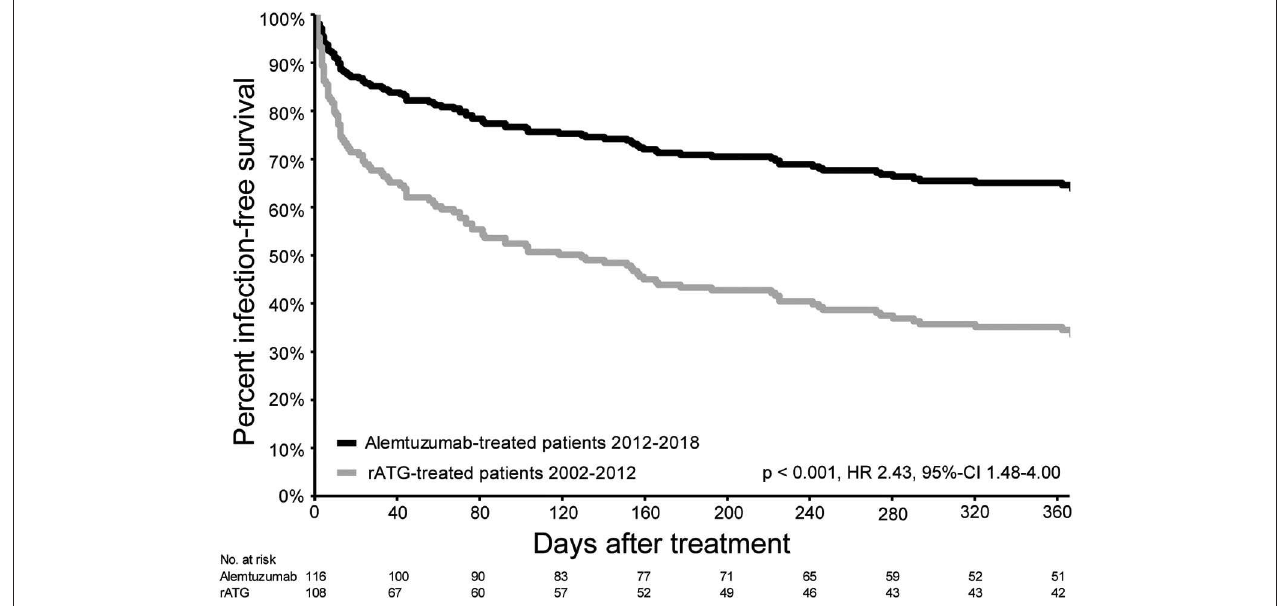
FIGURE 4 | Infection-free survival in the first year after treatment for acute rejection. Infection-free survival (excluding CMV, EBV, and BK virus infections) of patients with AR and treated with alemtuzumab (2012–2018) and patients treated with rATG for AR between 2002 and 2012.